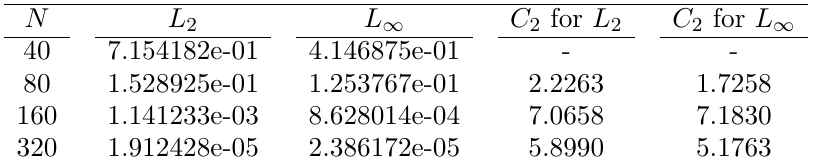
Table 1. Error norms and convergence orders for c = 4 / 3, p = 4 and increasing values of N at t = 0 . 1.